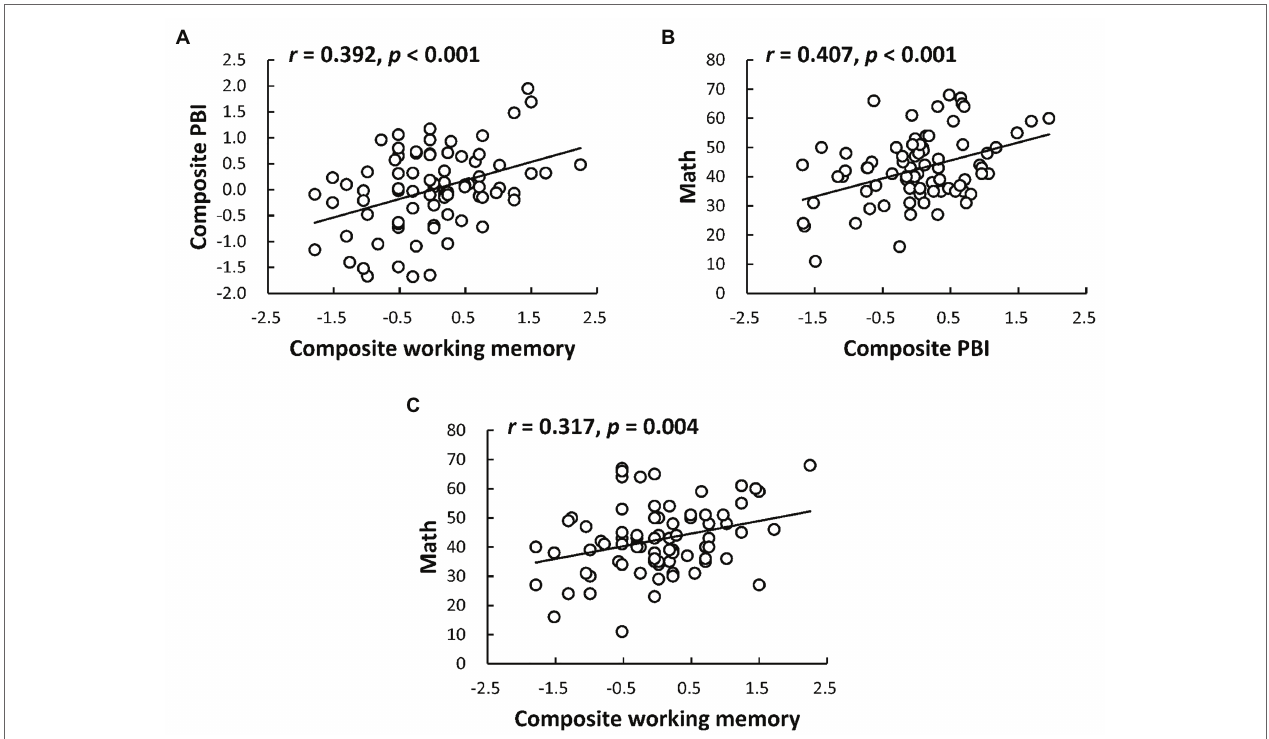
FIGURE 1 | Relationships among proactive control, working memory, and math ability. (A) Represents the relationship between proactive control and working memory; (B) represents the relationship between proactive control and math ability; and (C) represents the relationship between working memory and math ability.